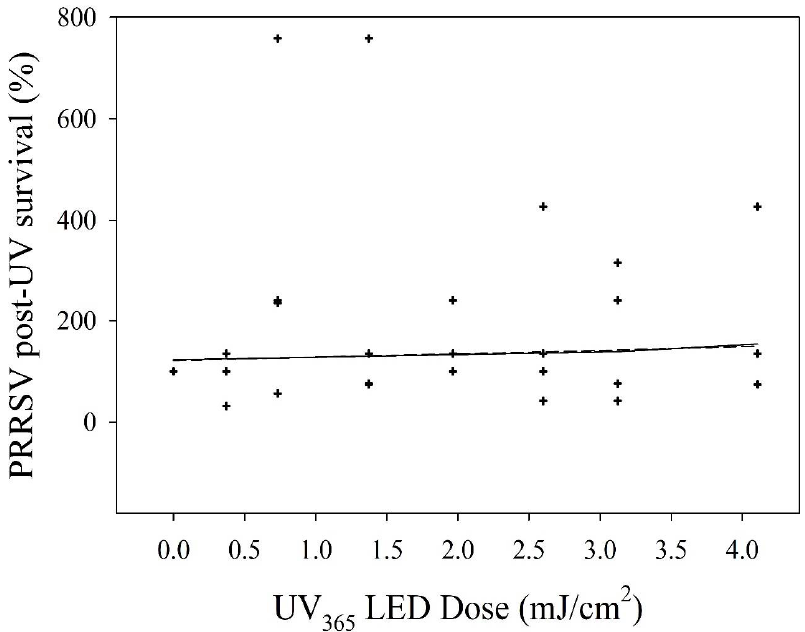
Figure 5. UV-A (365 nm, LED) treatment inactivation of aerosolized PRRSV. PRRSV post-UV survival (%) = N t /N 0 . A log 1supp0 normalized PRRSV post-UV survival is shown in Figure A4. One-stage and two-stage inactivation models are marked with dashed and solid lines, respectively.